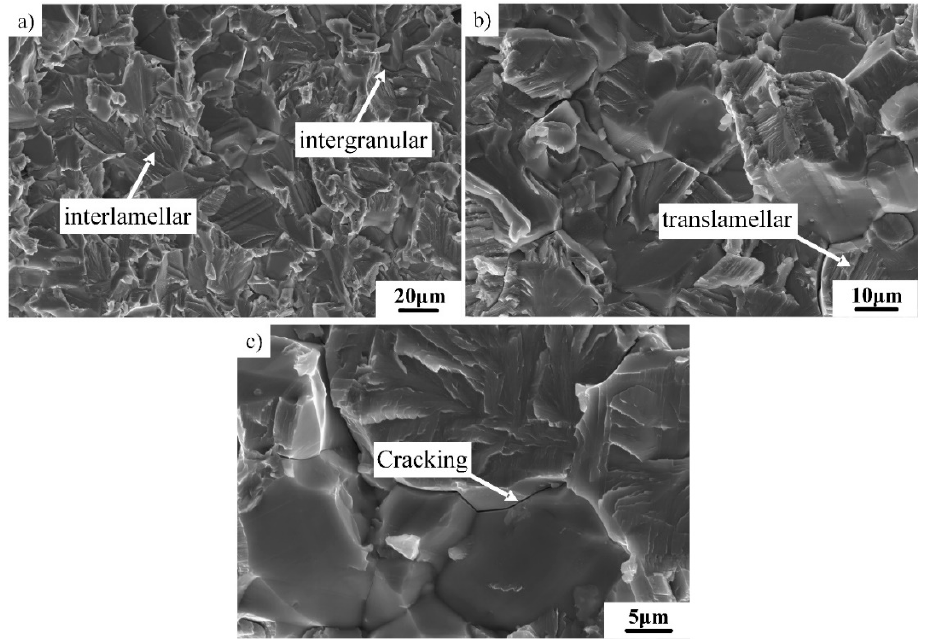
Figure 11. RT tensile fracture surfaces of Ti–43Al–2Cr–2Mn–0.2Y alloy with DP microstructure: ( a , b ) fracture feature and ( c ) cracking.